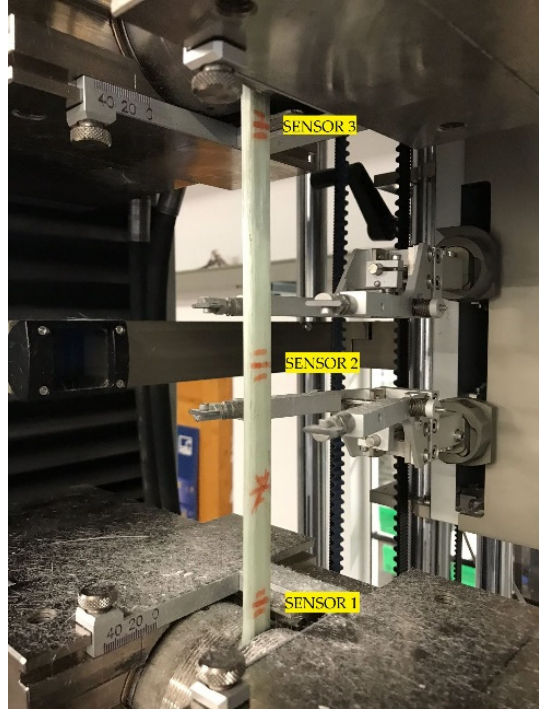
Figure 6. Sensorized beam test piece setting.